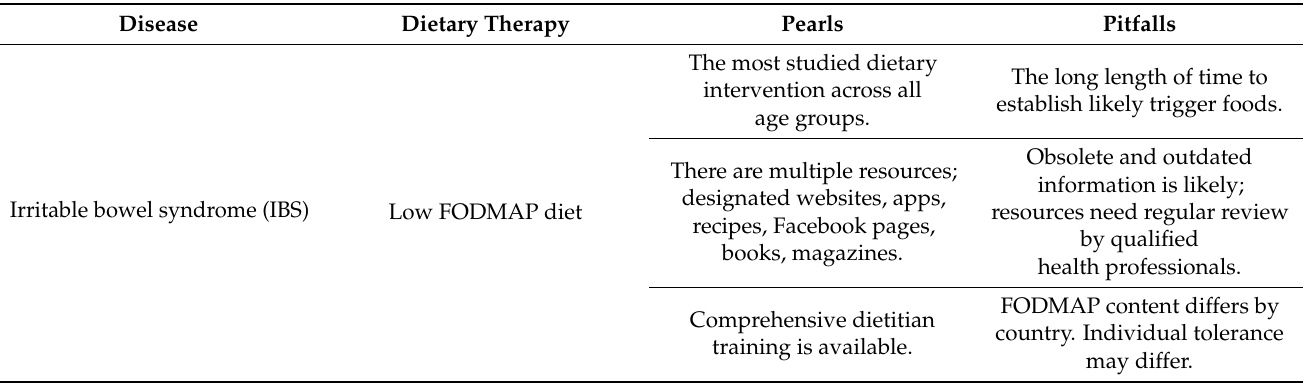
Table 3. The pearls and pitfalls of dietary therapies for the management of chronic diarrhoea.